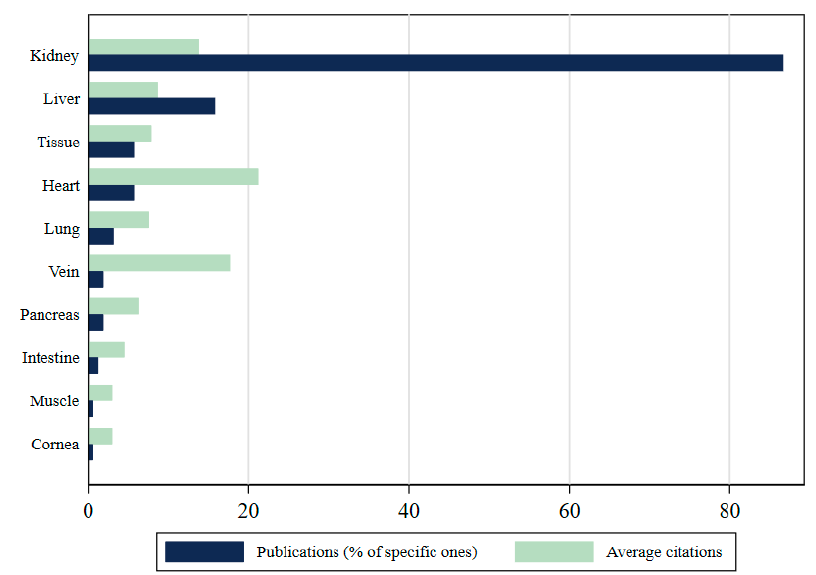
Figure 3. Most frequently studied organs in the trafficking of human beings for the purpose of organ removal (THBOR) research. Publications can simultaneously refer to more than one organ (percentages are out of 100).